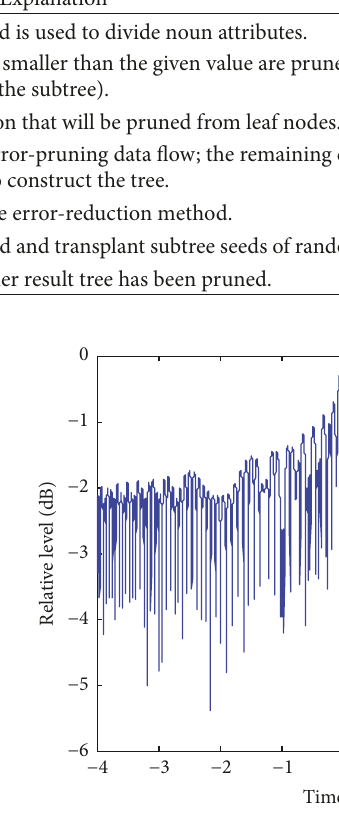
Figure 2: Outlier data signal model obtained using the traditional